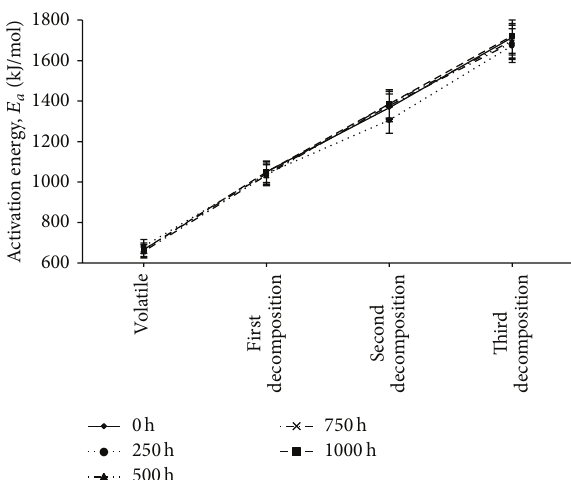
Figure 5: Activation energy of CB samples of UV irradiation.